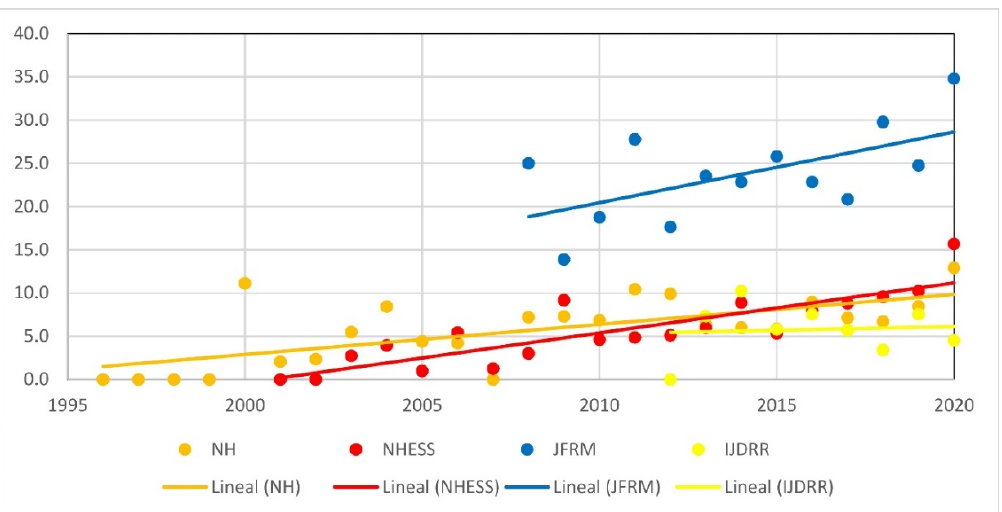
Figure 4. Percentages showing FRAs papers published in each journal versus the total papers published each year, and linear data adjustments.